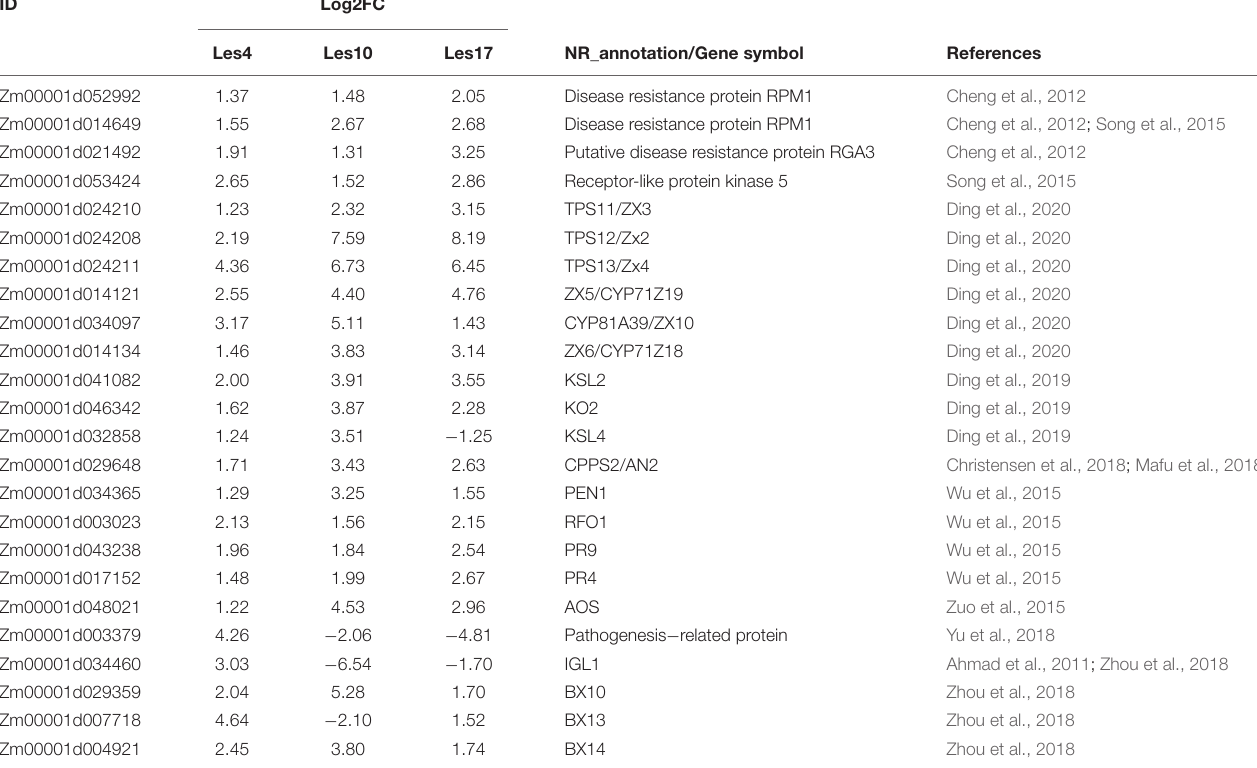
TABLE 1 | Representative common differentially expressed genes involved in plant defense response.